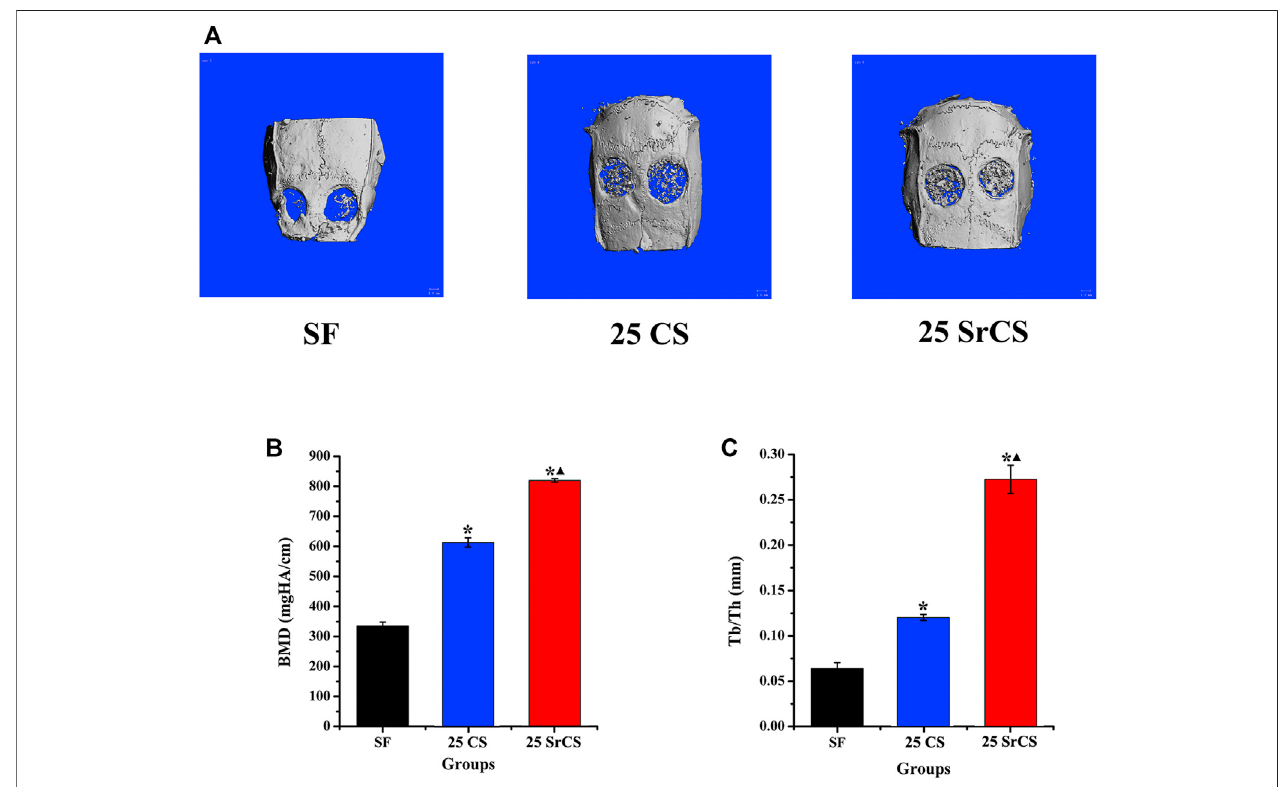
FIGURE 9 | Micro-CT evaluation and morphometric analysis of calvarial bone repairing. (A) Representative 3D super fi cial image of femur bone defects (bone grey thresholdrange: 120-255).Morphometric analysisofbone mineral density (BMD) (B) and trabecularthickness (Tb. Th) (C) bymicro-CTforeach group at 8 weeks post- operation. * p < 0.05 indicates the other groups vs. the SF group, and ▲ p < 0.05 indicates the 25 SrCS group vs. the other